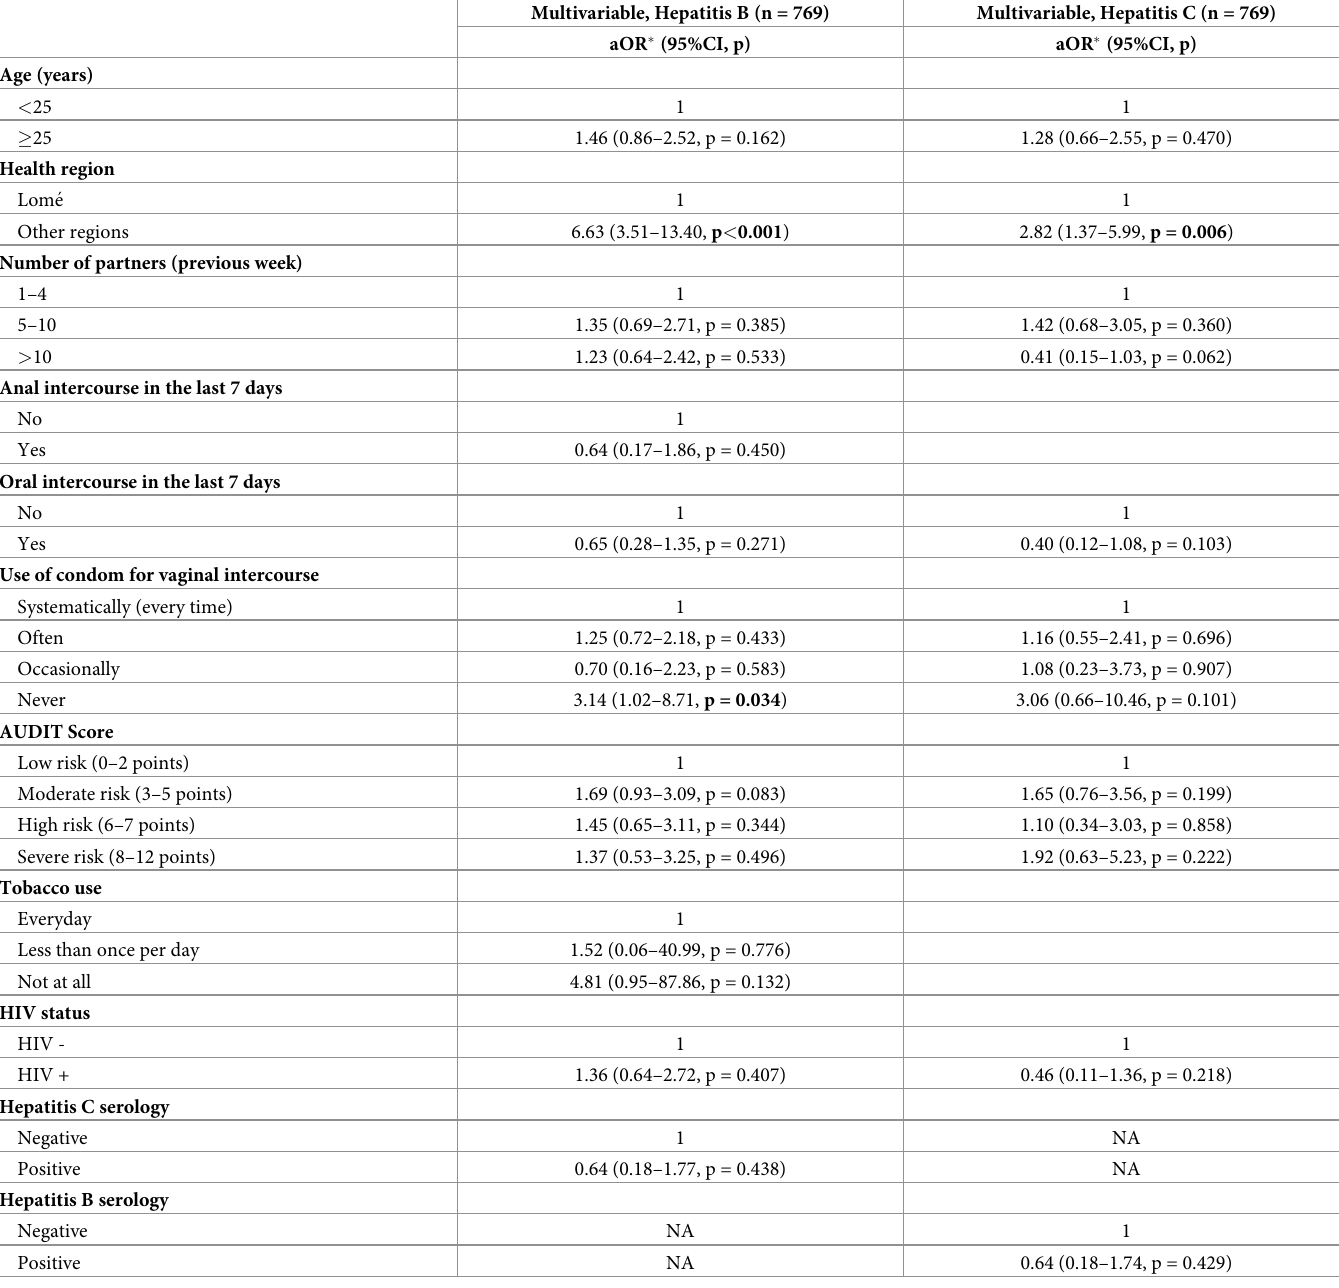
Table 5. Factors associated with hepatitis B and hepatitis C among female sex workers in